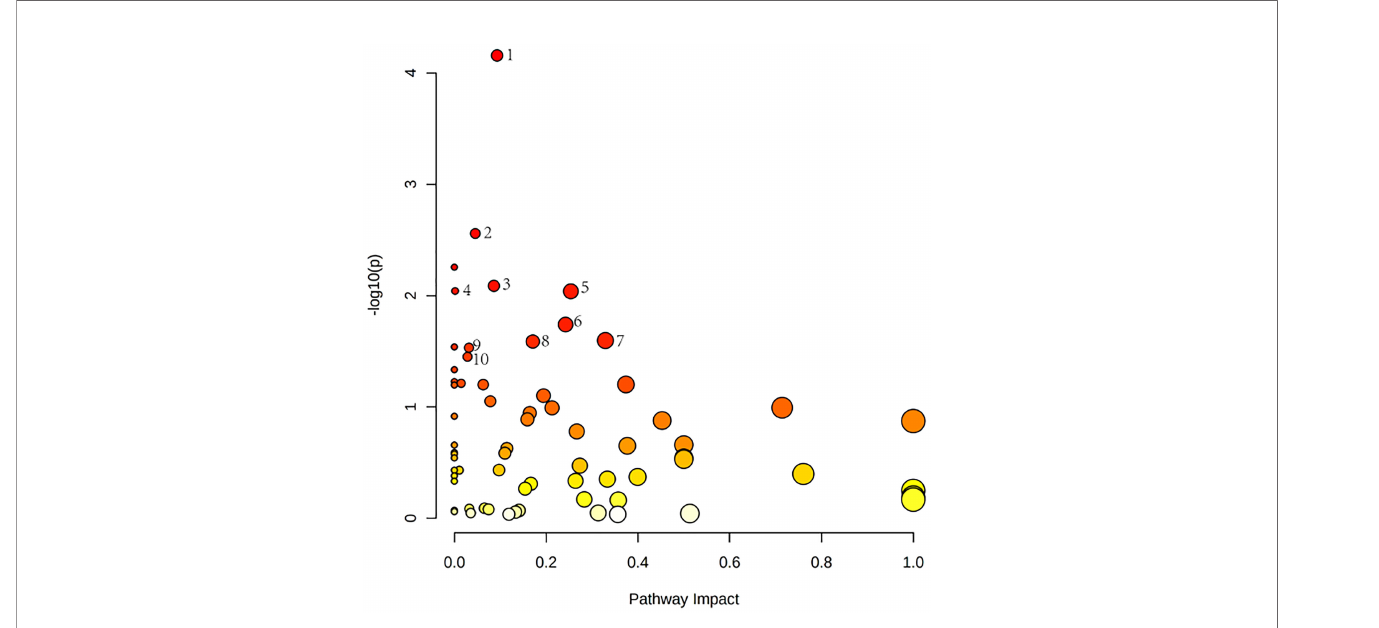
FIGURE 6 | Metabolomics reveals correlated differential metabolic pathways between normal, OP-OA, and EXD. (A) Metaboanalyst (http://www.Metabo-analyst.ca/) carried out metabolic pathway enrichment analysis, with P<0.05, 10 related metabolic pathways were